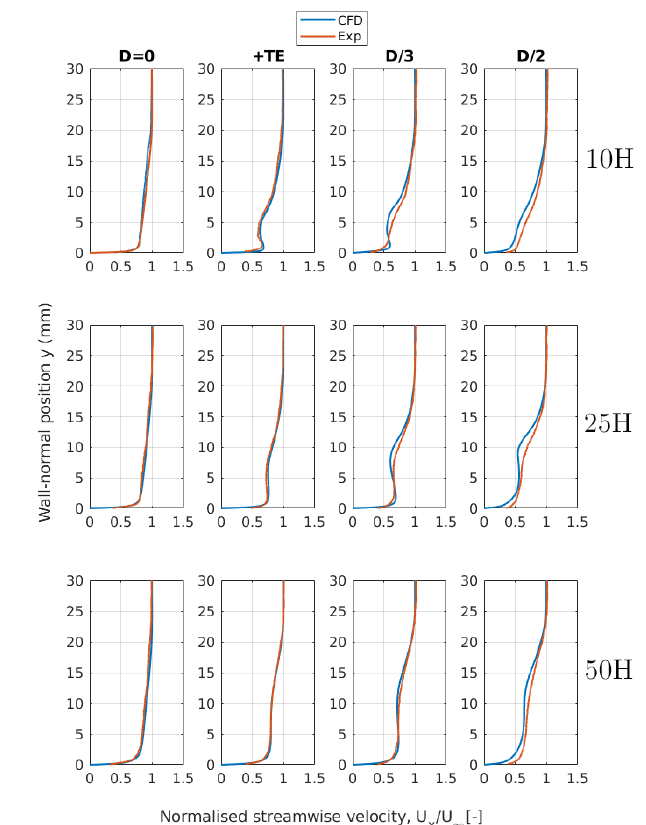
Figure 7. Normalized streamwise velocity profiles for the Rectangular VG at different streamwise locations 10H ( top ), 25H ( middle ) and 50H ( bottom ) from the trailing edge of the VG. Distance D = 30 mm is defined according to Figure